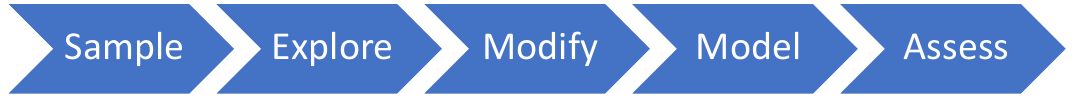
Figure 1. SEMMA (Sample, Explore, Modify, Model, and Assess) Methodology. Source: Own elaboration from SAS (SAS: Analytics, Artificial Intelligence and Data Management 2020).